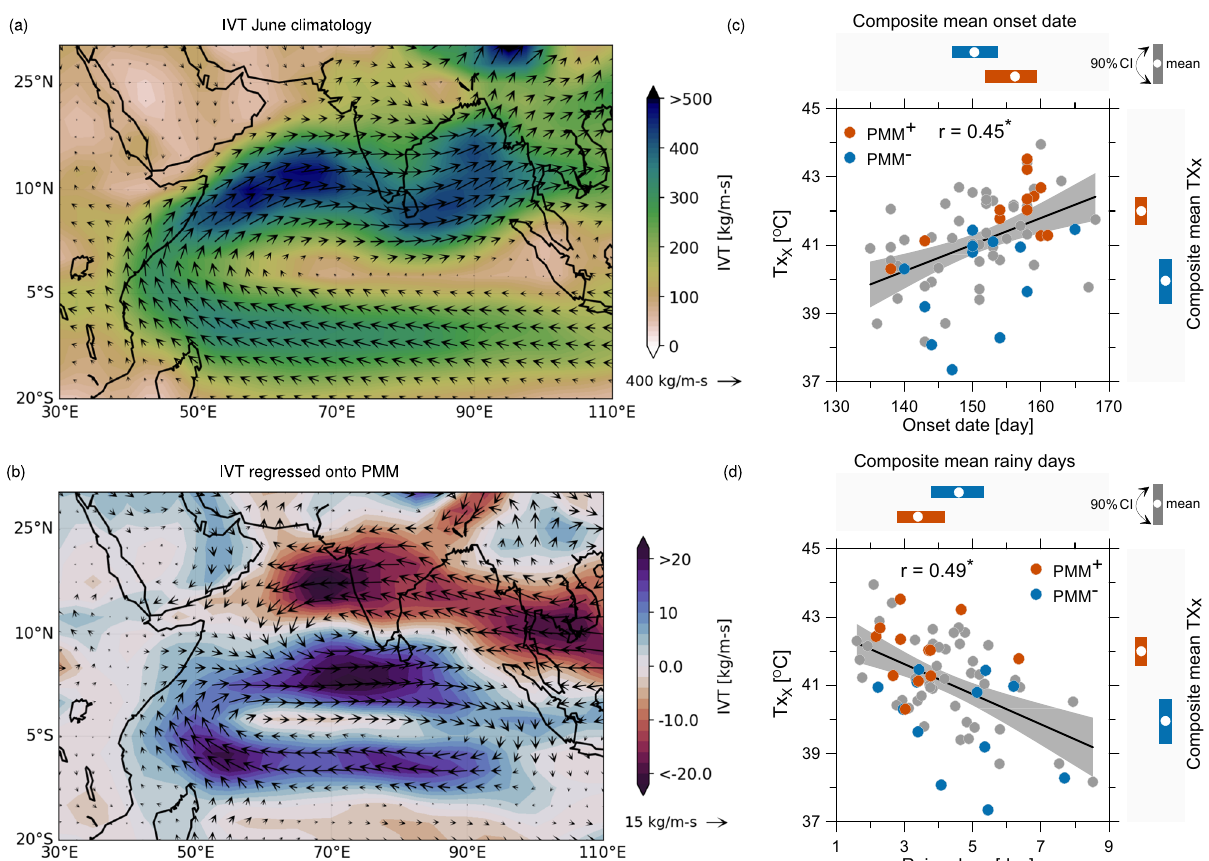
Fig. 3 | Implications of the large-scale patterns associated with the Paci fi c Meridional Mode (PMM) towards the moisture transport and onset of Indian monsoons.a CharacteristicsofJuneclimatologyofmoisturetransport,intermsof integrated vapor transport (IVT) 72 during the period 1951 – 2019. Majority of moisturesourceforIndiaduringJune(monsoononsetperiod)isgenerallyfromthe north Indian Ocean – of which the Arabian Sea region is the dominant source 44,45 . b The response of IVT to leading PMM index shows the inhibition of moisture transport to the Indian mainland from the adjacent north Indian ocean due to